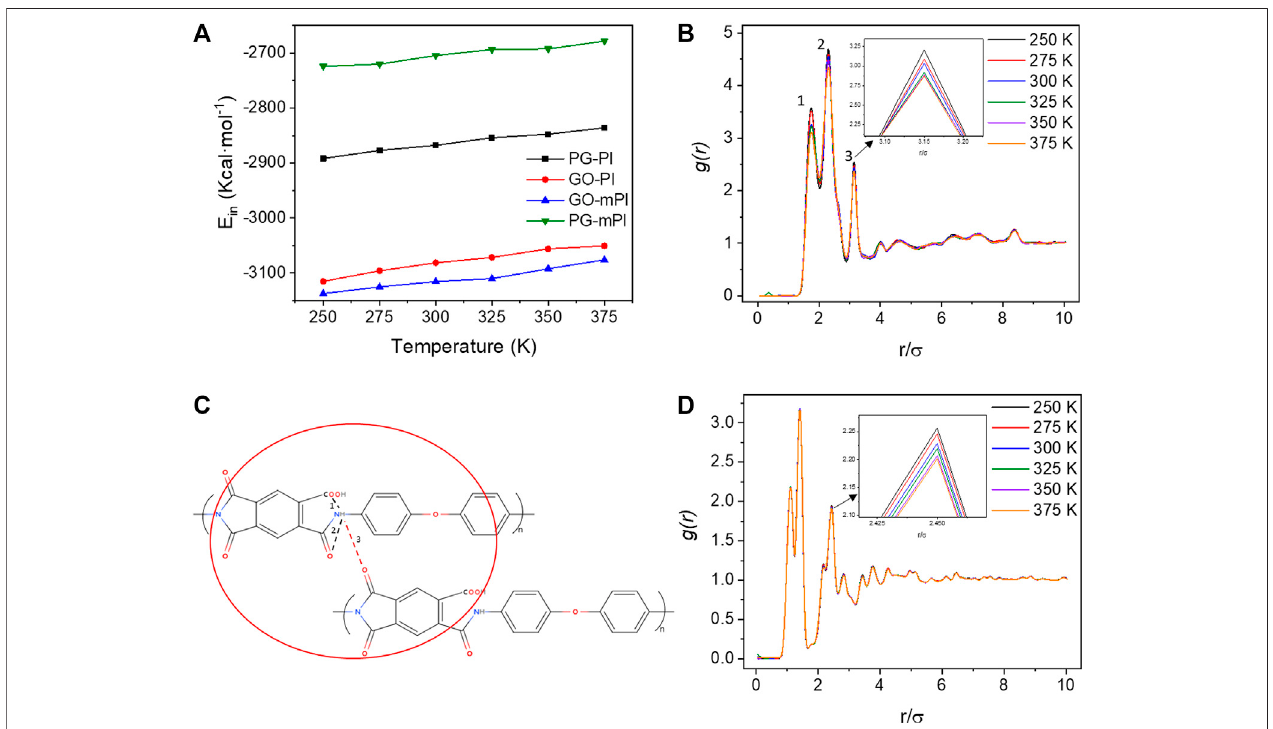
FIGURE 1 | (A) The interaction energies E in under different temperatures; (B) NH-CO RDF of mPI/GO under different temperatures, inset graph: ampli fi ed peak 3; (C) Scheme of peaks 1, 2, 3; (D) all-to-all RDF of